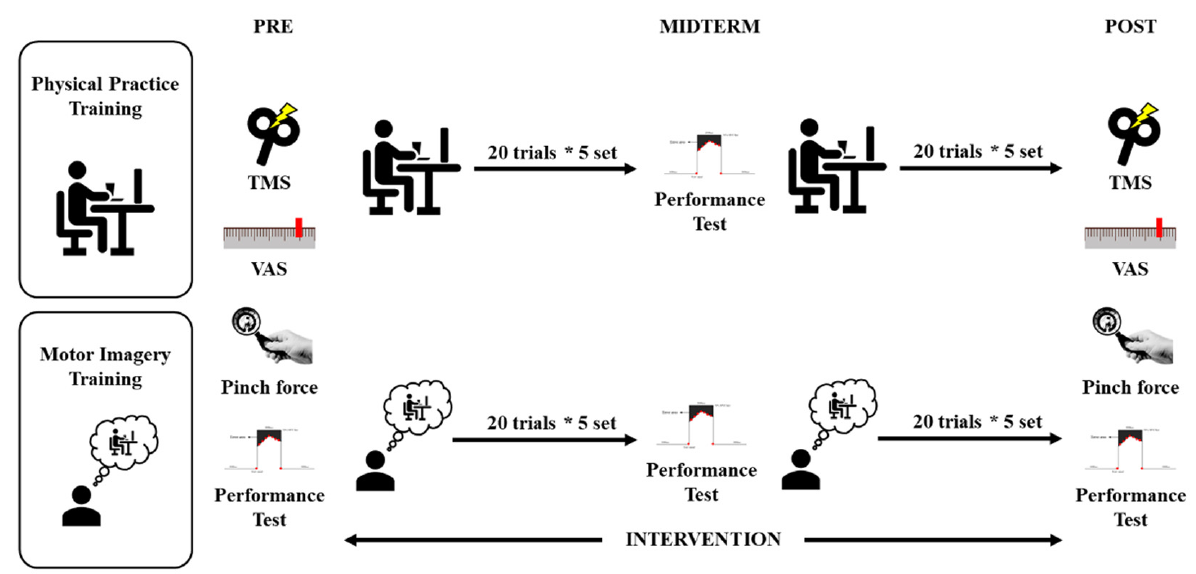
Figure 2. Experimental protocol. TMS, transcranial magnetic stimulation; VAS, visual analog scale; *, multiply.